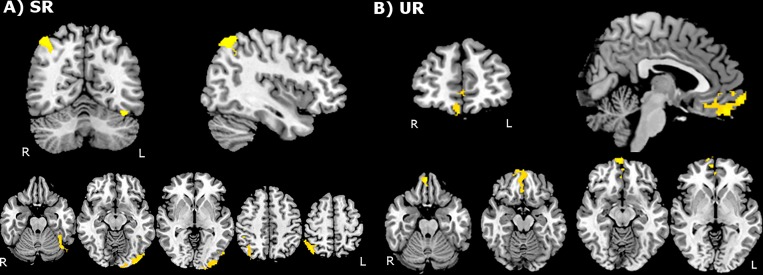
Between-group comparison showing probabilistic activation map before training.A) 'SR' condition. B) ‘UR' condition. Clusters in orange-yellow threshold indicate higher activations in adolescents. Images are shown in radiological orientation. SR–semantically related; UR–unrelated.